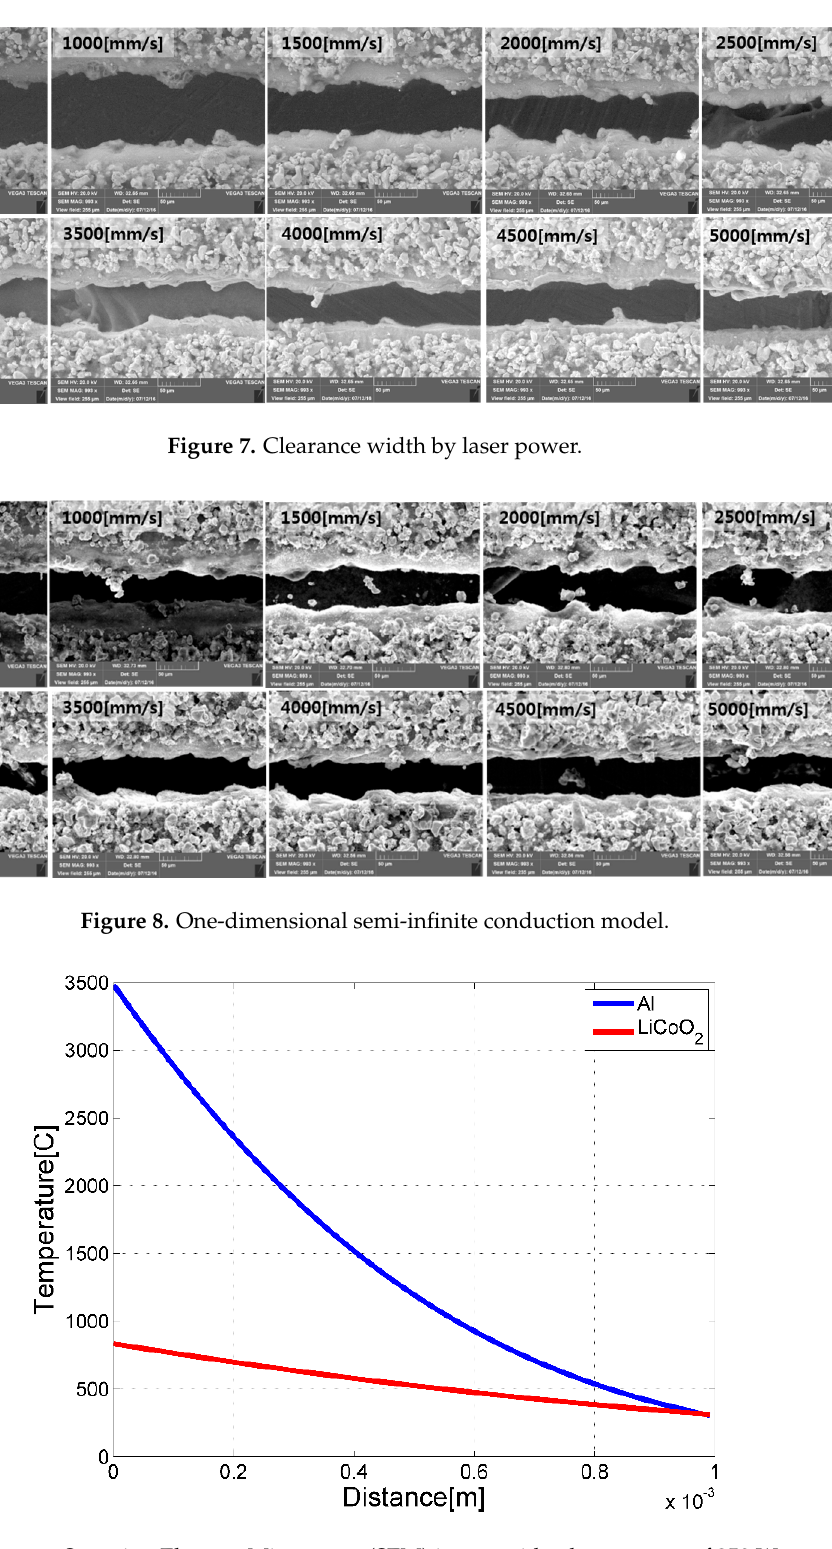
Figure 8. One-dimensional semi-infinite conduction model.